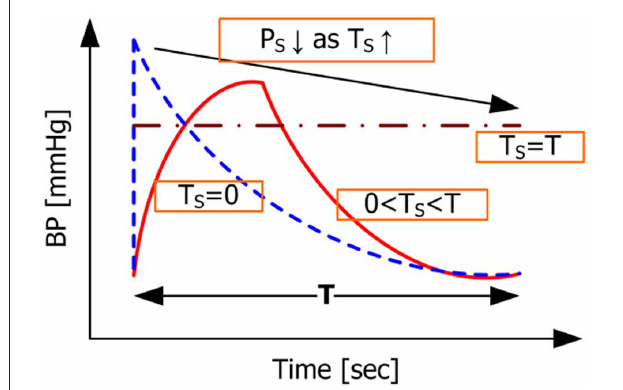
FIGURE 4 | Model-predicted BP waveforms associated with different values of T S